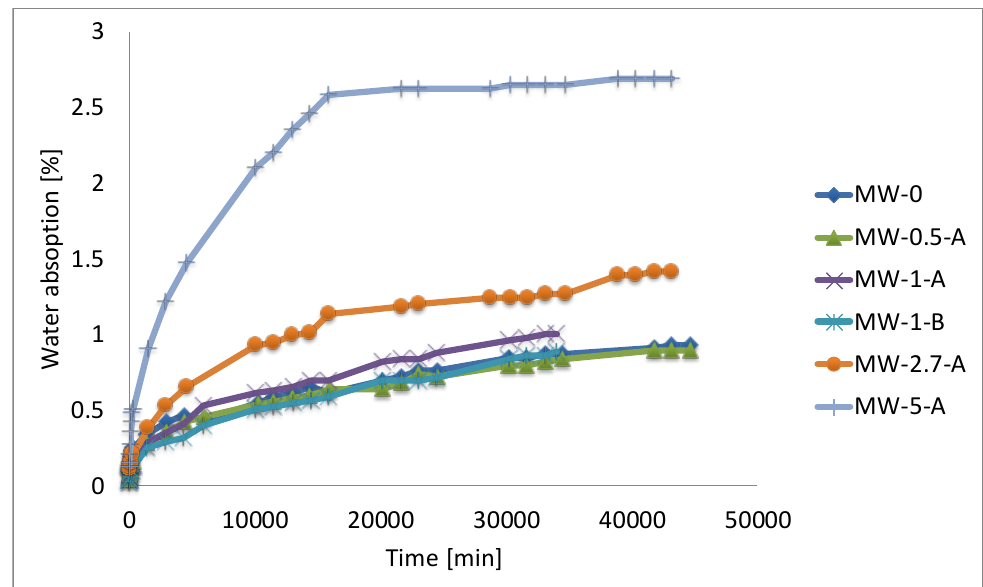
Figure 5. Water absorption for the different samples.